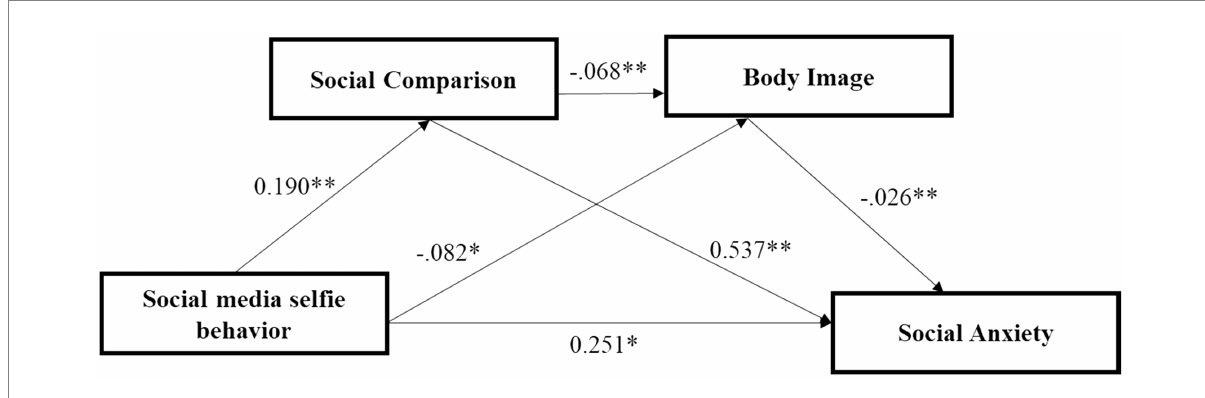
FIGURE 1 Process-conditional model of the association between social media selfie behavior and social anxiety. * p < 0.05; ** p <